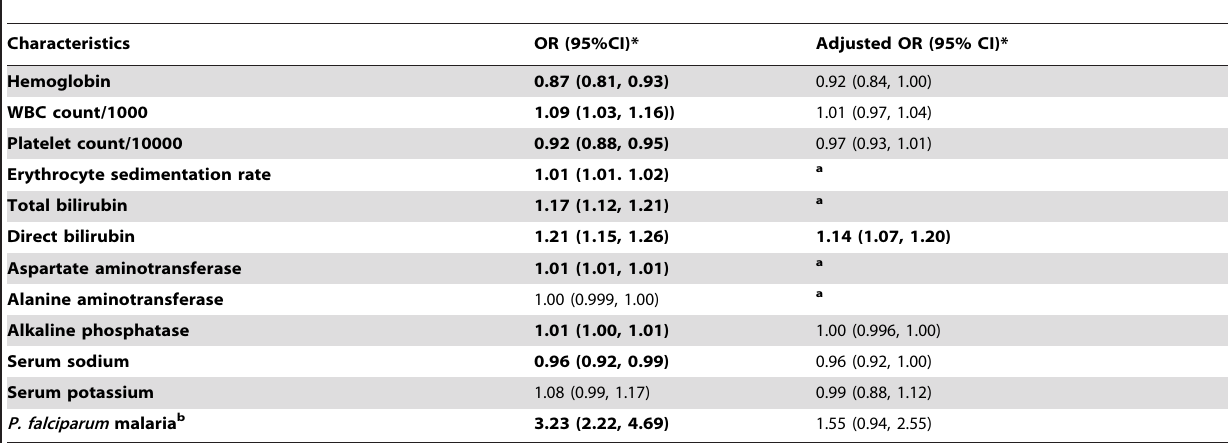
Table 6. Univariate and Multivariate Analysis for Laboratory Factors Associated with AKI.